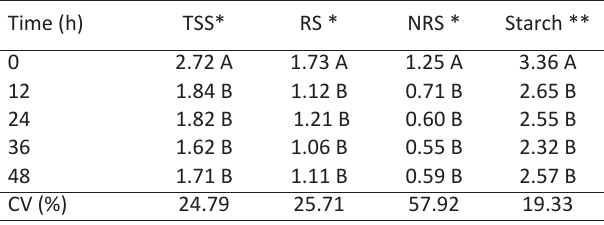
Table 3 - General mean values of total soluble sugars (TSS), reducing sugars (RS), non-reducing sugars (NRS) and starch contents in 'Lucy Brown' icerberg lettuce stored at 5 or 22°C during the first 48 h of shelf life storage